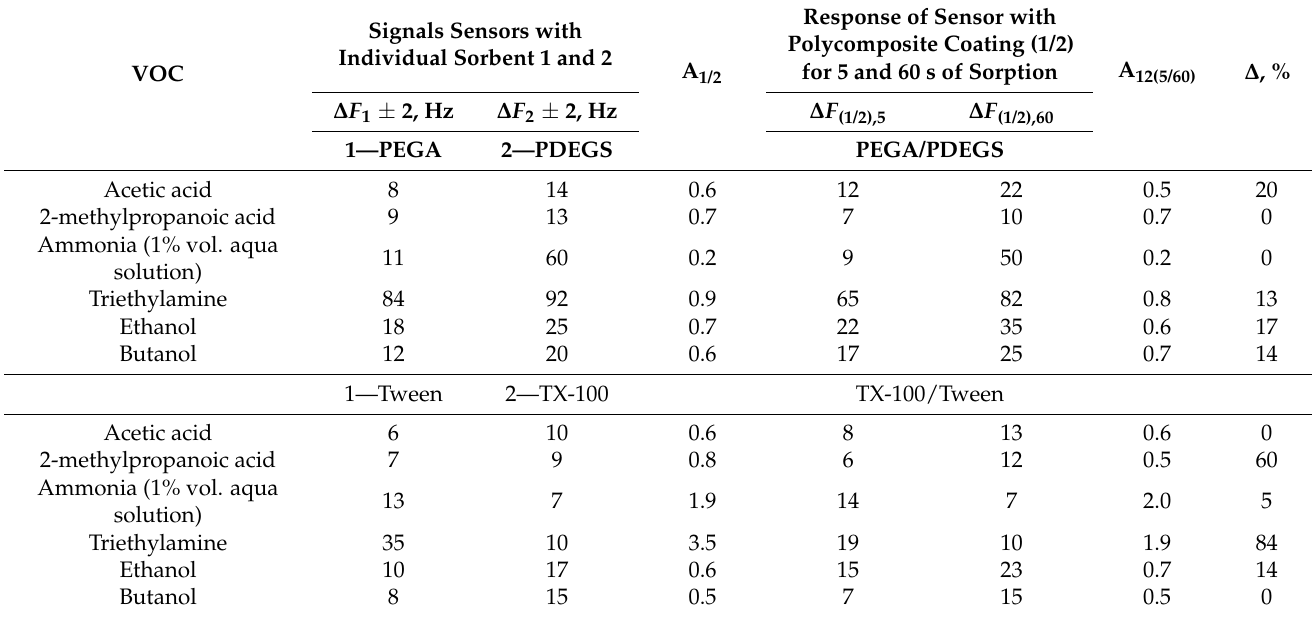
Table 10. VOC sorption efficiency parameters A ij (5/60) for polycomposite coatings and an array